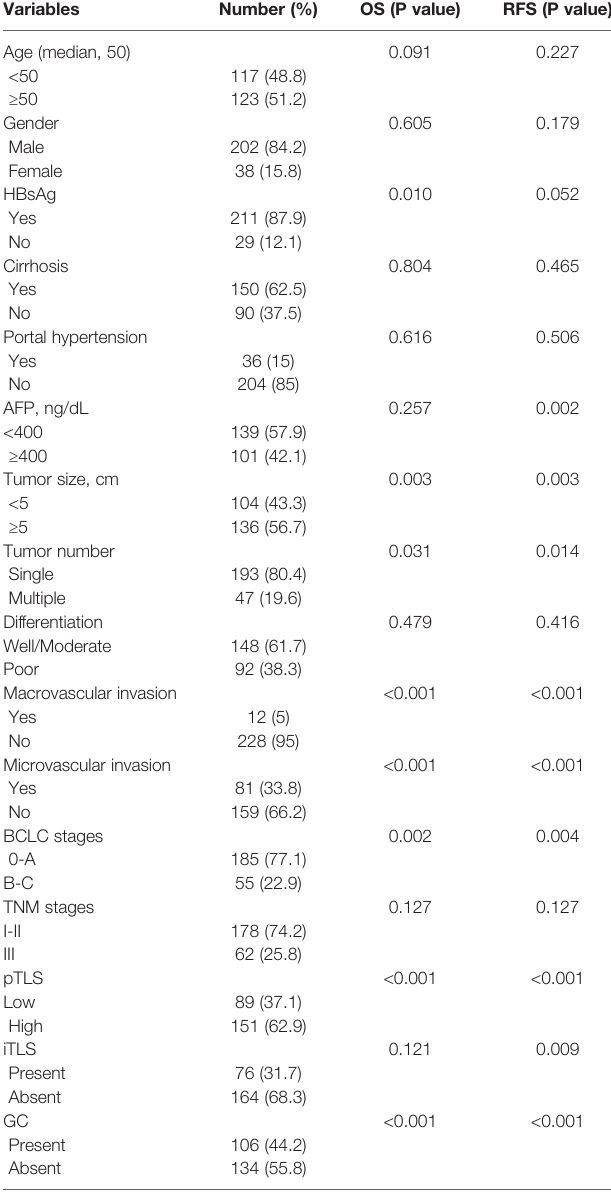
TABLE 1 | Baseline characteristics of 240 HCC patients and univariate analysis of factors possibly affecting the survival.